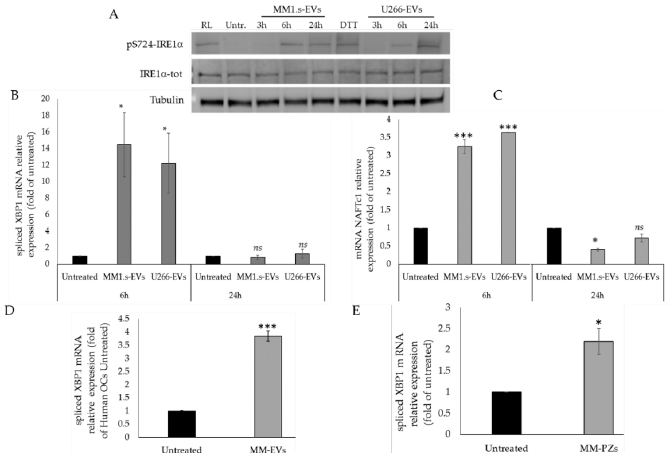
Figure 2. ( A ). Western blotting analysis of pS724-IRE1α and IRE1α-tot in Raw264.7 cells treated with 25 μg/mL of MM1.s-EVS and U266-EVs for 3, 6 and 24 h; as positive controls, Raw264.7 cells were also treated with 25 ng/mL of hrRANKl (RL) and 10 mM DTT (reducing agent used as unfolded protein response (UPR) inducer). Tubulin was used as loading control. ( B ). qRT-PCR analysis of XBP1 spliced in Raw264.7 cells treated for 6 and 24 h with 25 µ g / mL of MM1.s-EVs and U266-EVs. Data were normalized for GAPDH and values are expressed as fold of control (untreated